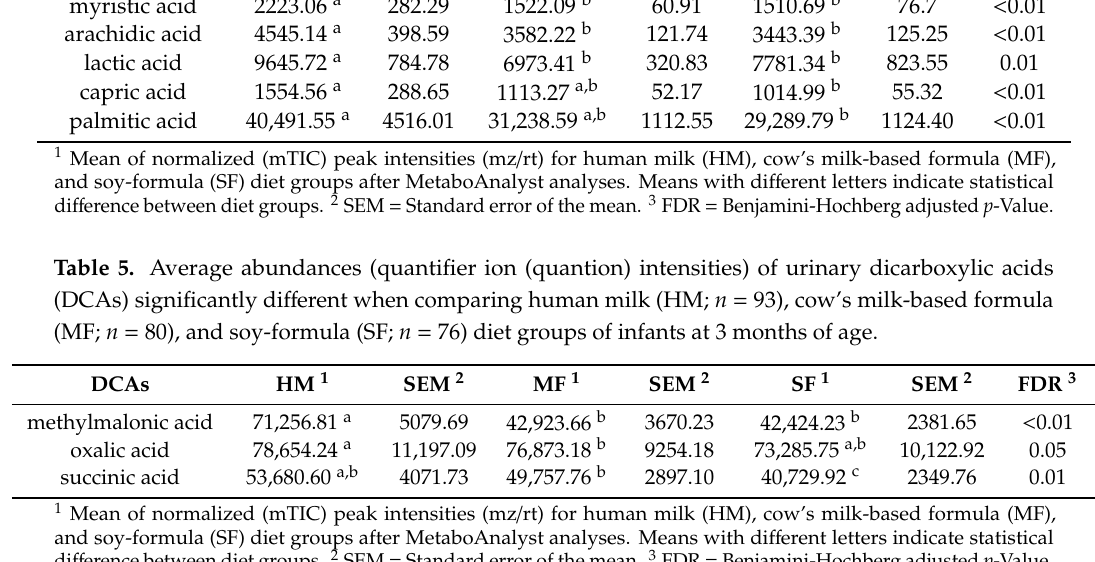
di ff erence between diet groups. 2 SEM = Standard error of the mean. 3 FDR = Benjamini-Hochberg adjusted p -Value.